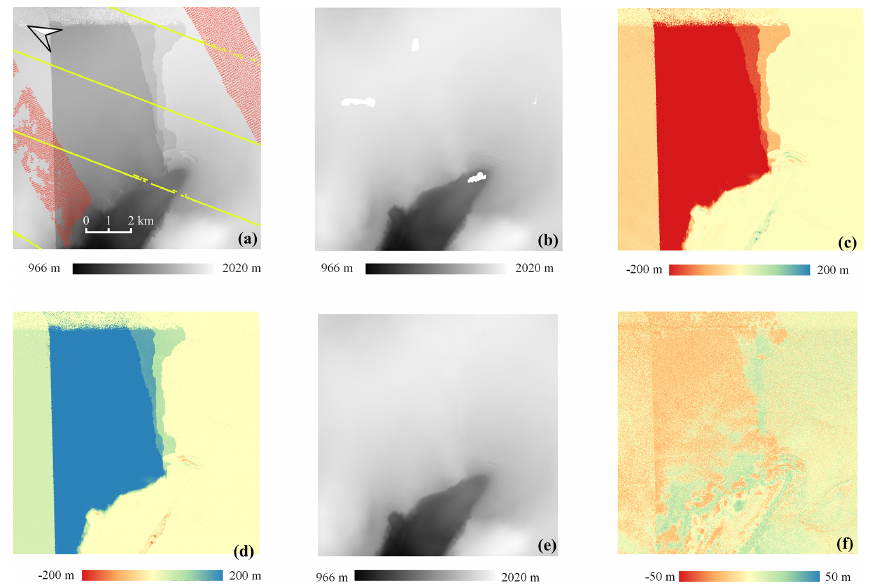
Figure 6. Experimental results in a local 11 × 11km 2 sample area. (a) Original TDM DEM. Red and yellow: the footprints of LVIS 2015 and ATL06 2019. (b) Original REMA mosaic elevations with unfilled voids. (c) Elevation difference: TDM DEM minus REMA mosaic. (d) Correction map as obtained with Eq. (3). (e) Corrected TDM DEM. (f) Residual elevation difference: corrected TDM DEM minus REMA